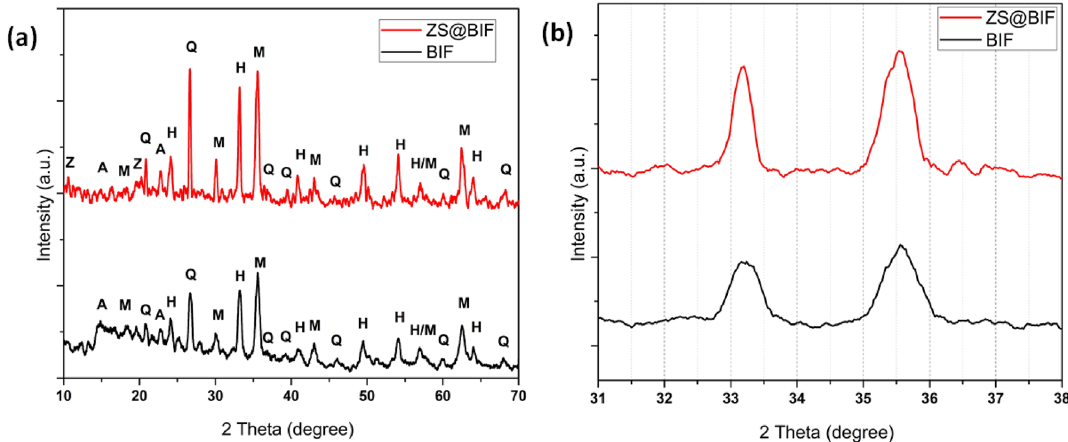
Figure 1. ( a ) XRD patterns of banded iron formation (BIF) and zinc stearate@banded iron formation composite (ZS@BIF), ( b ) Shift of XRD peaks to lower angles. [Albite (A), Hematite (H), Magnetite (M), Quartz (Q), Zinc stearate